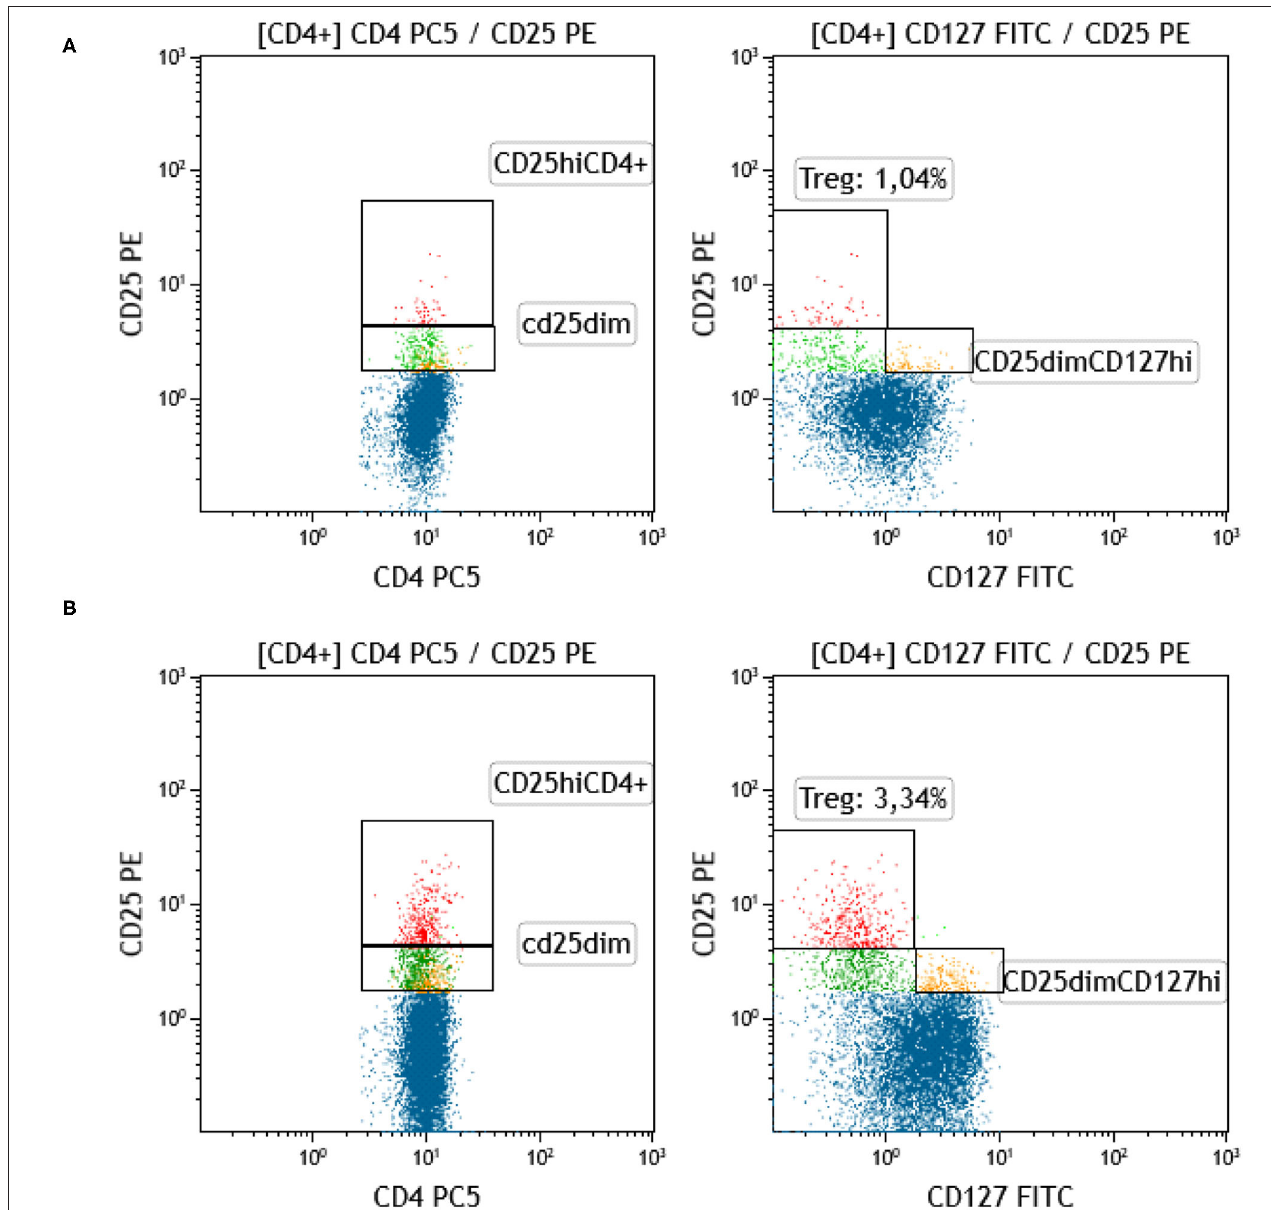
FIGURE 7 | Identification and quantification of T-reg in patients with a different allelic burden. (A) Patient with no chimeric alleles detected. (B) Patient with five chimeric alleles detected (red: T-reg [CD4 + CD25 hi CD127–], blue: CD4 + CD25–, green: CD4 + CD25 dim CD127–, yellow: CD4 + CD25 dim CD127 + ).